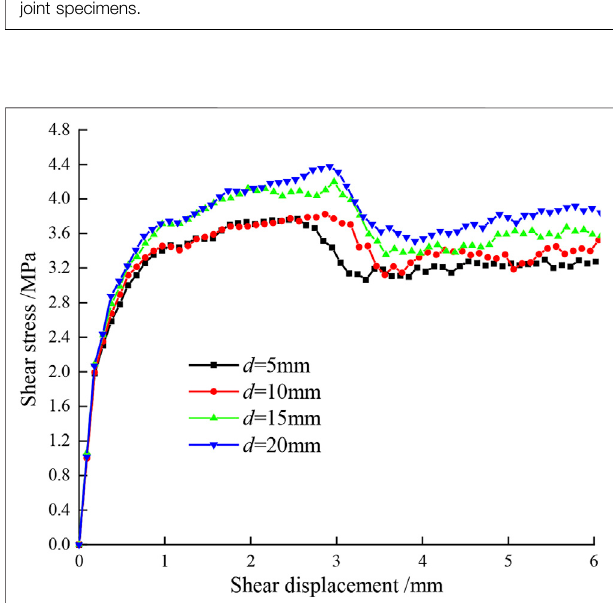
FIGURE 6 | Shear-normal displacement relation of single- and double- joint specimens.